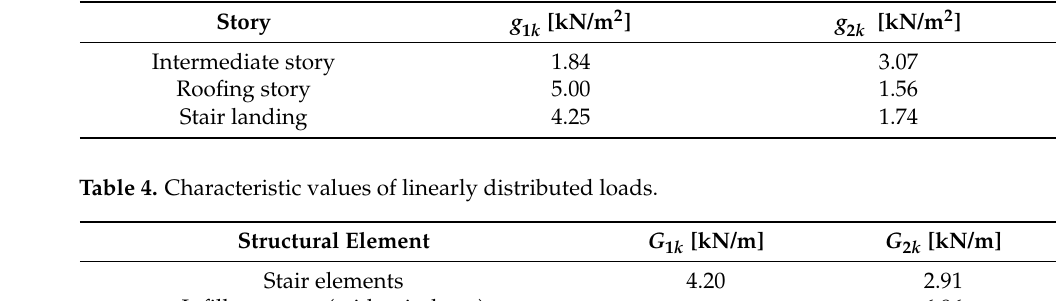
Table 3. Characteristic values of structural and non-structural dead loads.